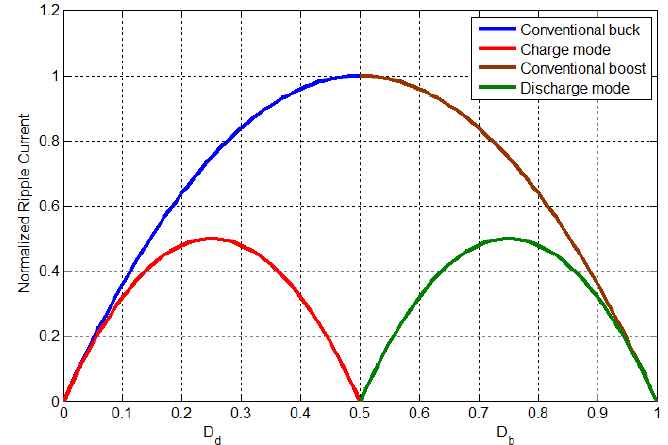
Figure 10. Normalized inductance ripple current versus duty ratio of the conventional buck, boost and the proposed converter for charge and discharge operations,